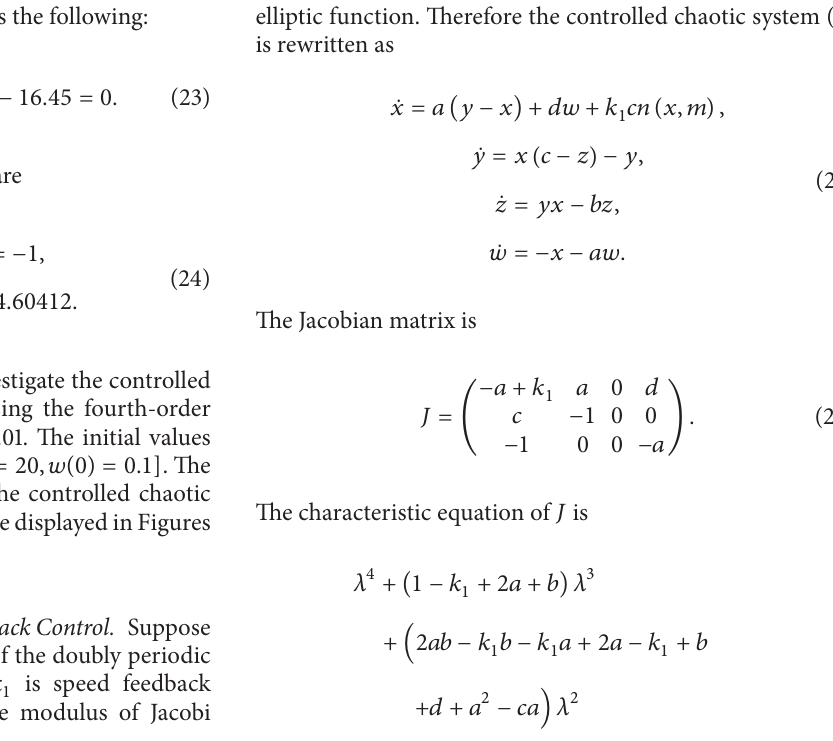
𝑧 1 (the dashed line) and